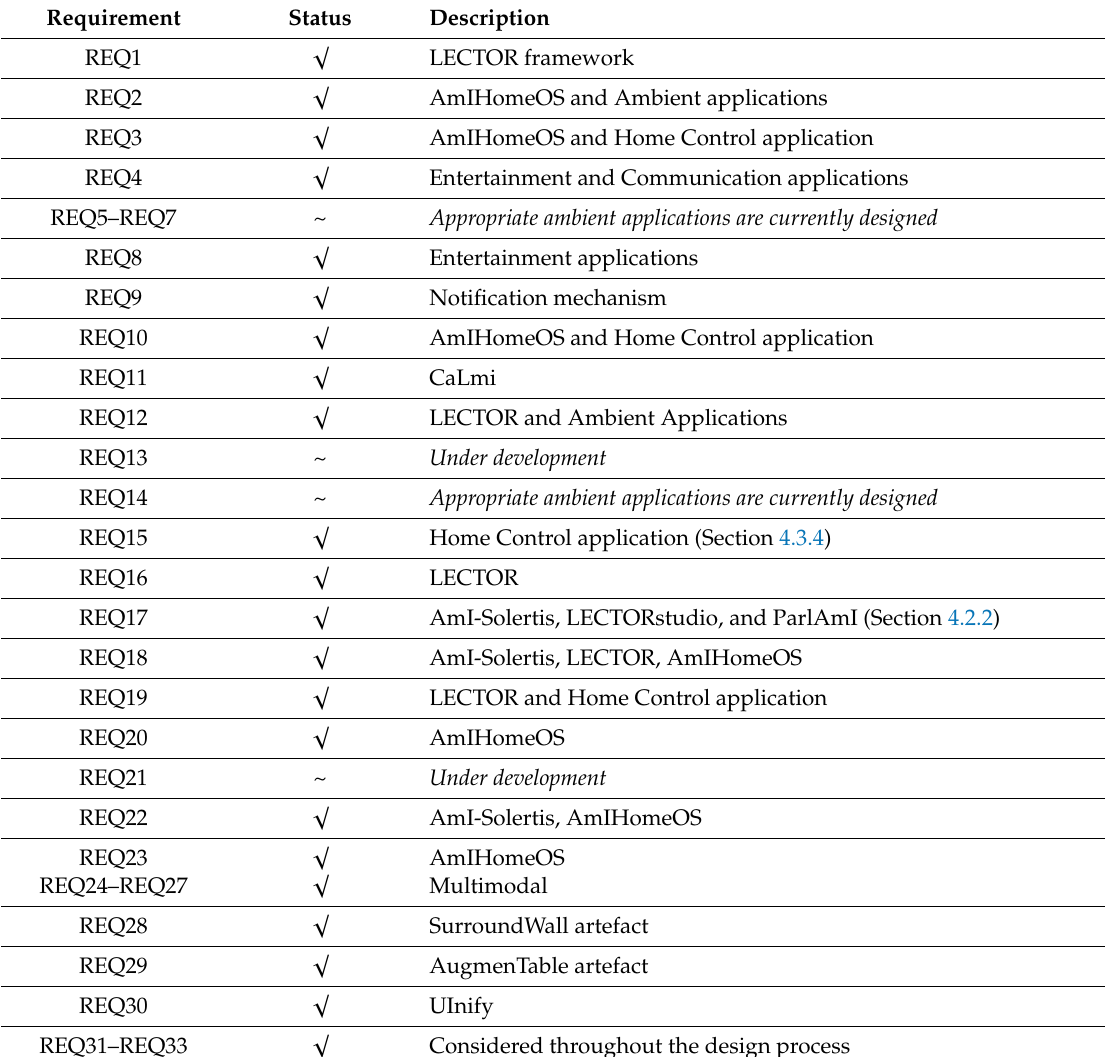
Table 1. Requirements fulfilment